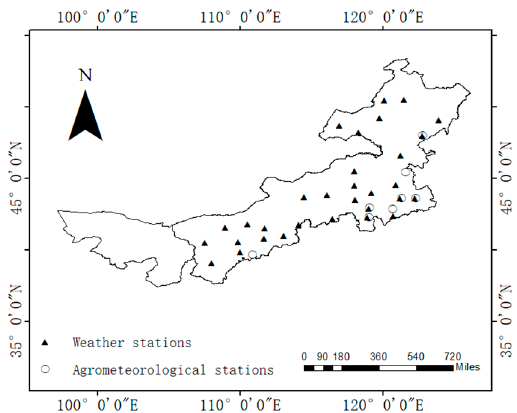
Figure 1. Distribution of weather and agrometeorological stations in Inner Mongolia.